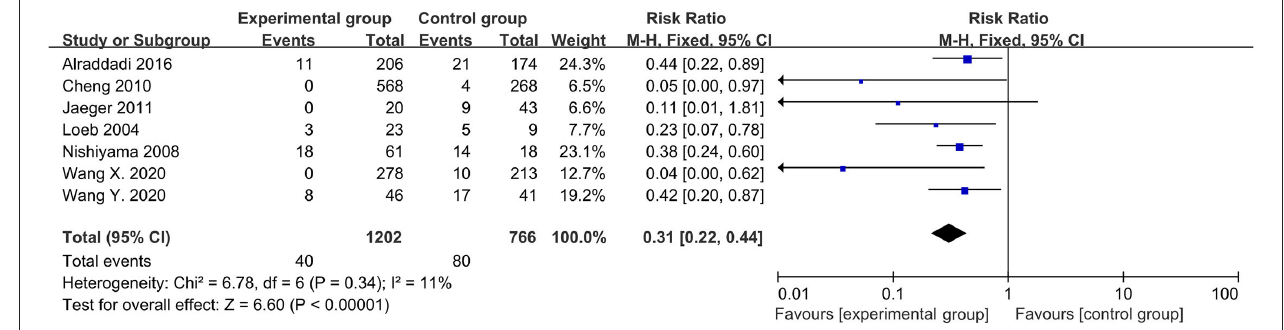
FIGURE 3 | Forest plot of meta-analysis of cohort studies.